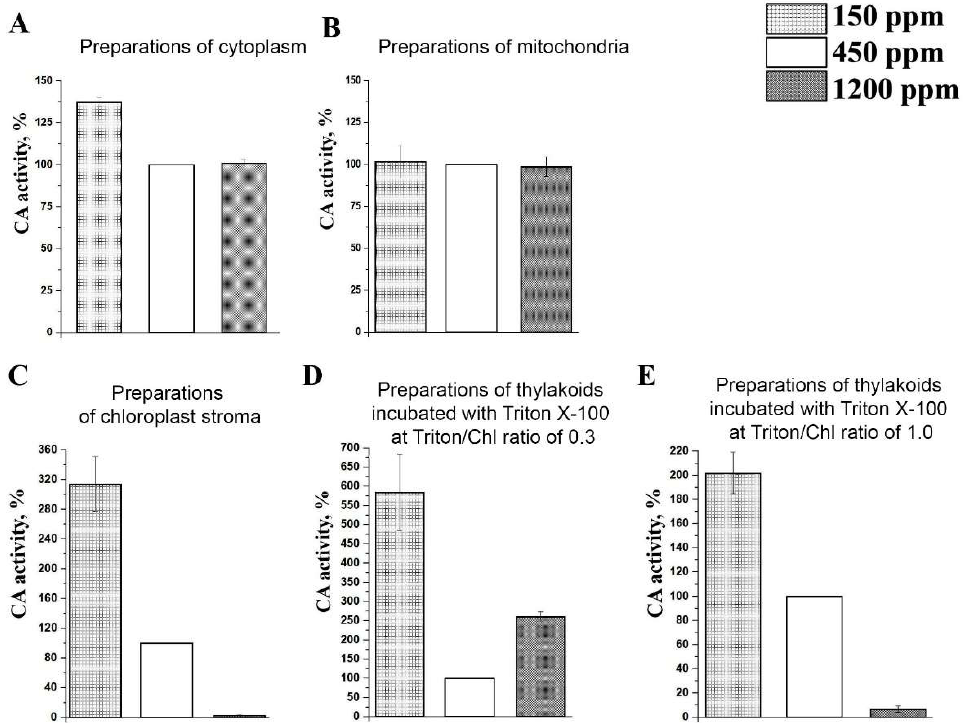
Figure 4. Carbonic anhydrase activities of preparations isolated as described in Materials and Methods from two-month-old Arabidopsis plants after 16 days of acclimation to low (150 ppm), and high (1200 ppm) CO 2 levels in the air. The 100% value is the CA activity of preparations isolated from the leaves of Control plants of the same age grown at 450 ppm of CO 2 . Data are shown as mean ± the SE. ( A )—preparations of cytoplasm. Briefly, 100% is 941.30 µ mol H + (min − 1 ) (mg Pr − 1 ). ( B )—preparations of mitochondria, incubated with 1% Triton X-100. In total, 100% is 7093.50 (min − 1 ) (mg Pr − 1 ). ( C )—preparations of chloroplast stroma. In addition, 100% is 9896.50 µ mol H + (min − 1 ) (mg Pr − 1 ); ( D )—preparations of thylakoids incubated with Triton X-100 at Triton/Chl ratio of 0.3. In total, 100% is 148.5 µ mol H + (min − 1 ) (mg Chl − 1 ). ( E )—Preparations of thylakoids incubated with Triton X-100 at a Triton/Chl ratio of 1.0. In brief, 100% is 201.00 µ mol H + (min − 1 ) (mg Chl − 1 ).